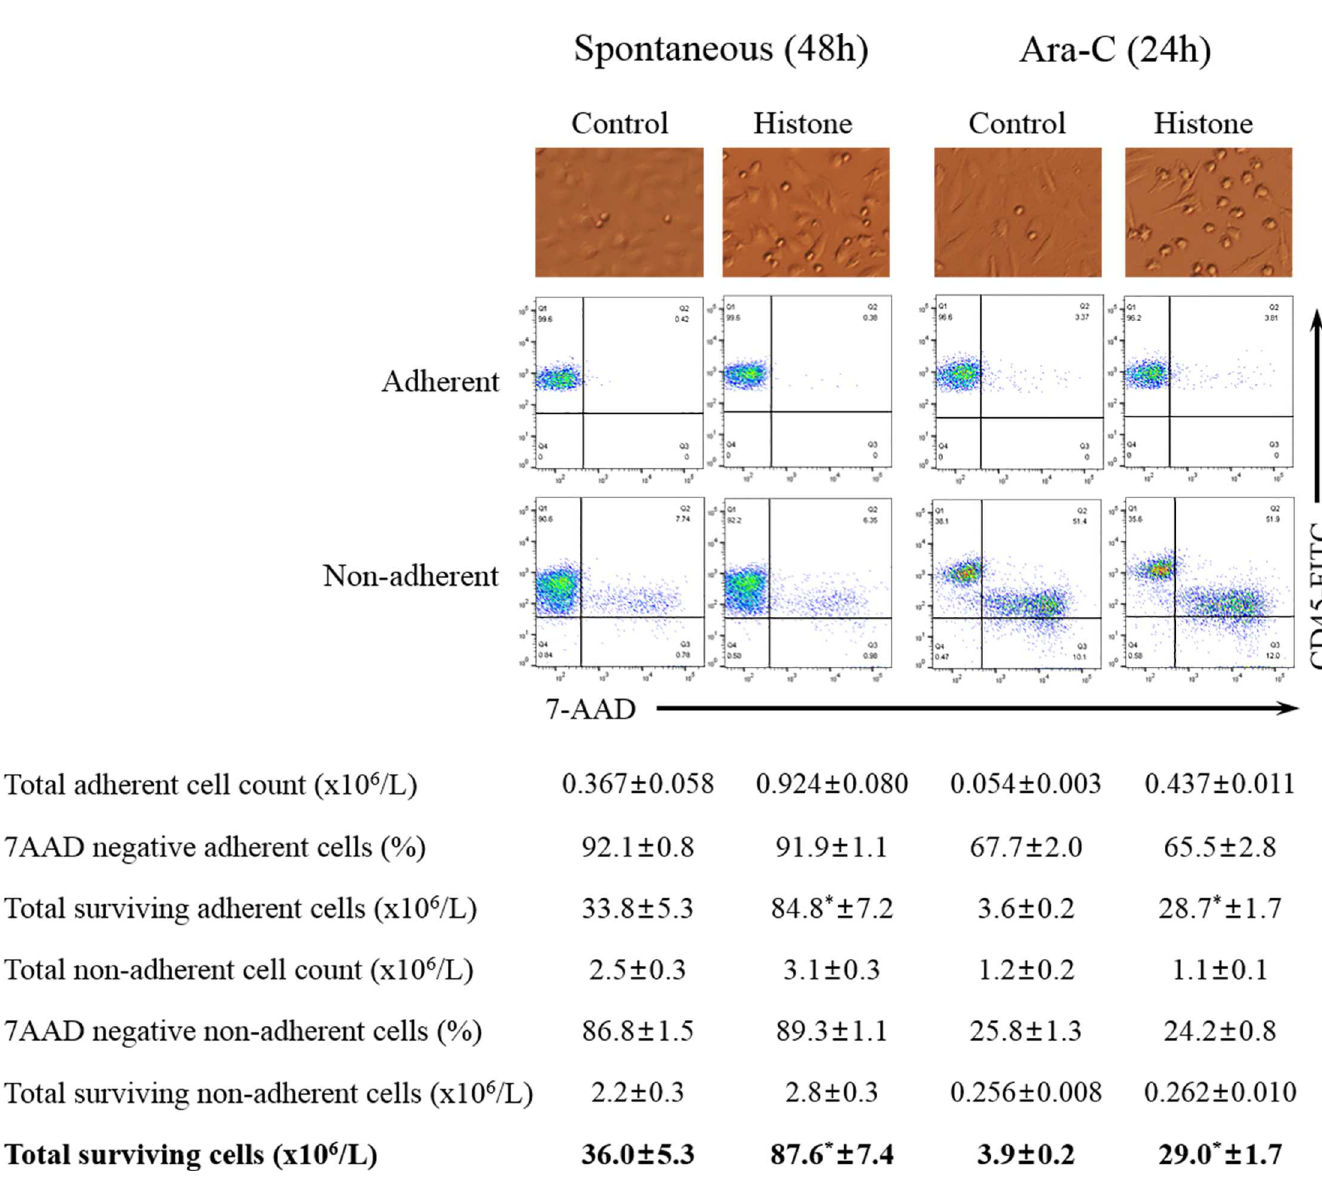
Fig 6. Survival of leukemic cells is increased by their adhesion to histone-treated endothelial cells (EA.hy926). Representative adhesionassay images and flow cytometry plots of CD45 and 7-AAD staining of adherent and non-adherent U937 cells in experiments on spontaneouscell death (48 h) and Ara-C-induced cell death (24 h). Total surviving cells are the sum of total survivingadherent cells and total surviving non-adherent cells. * P < 0.05 versus